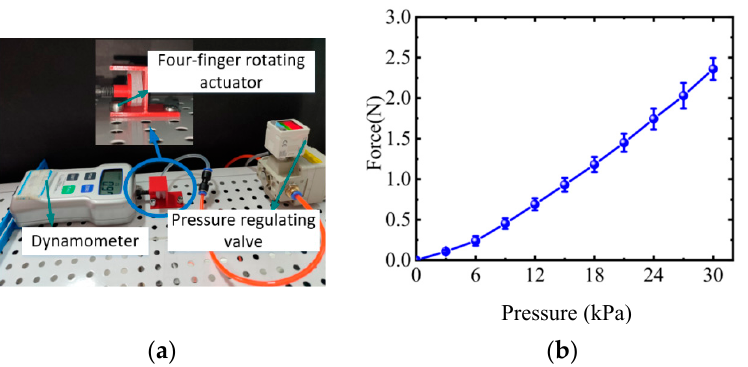
Figure 16. Mechanical characteristics test of rotating actuator for four fingers. ( a ) Force test of rotating actuator. ( b ) Force–pressure curve of rotating actuator.